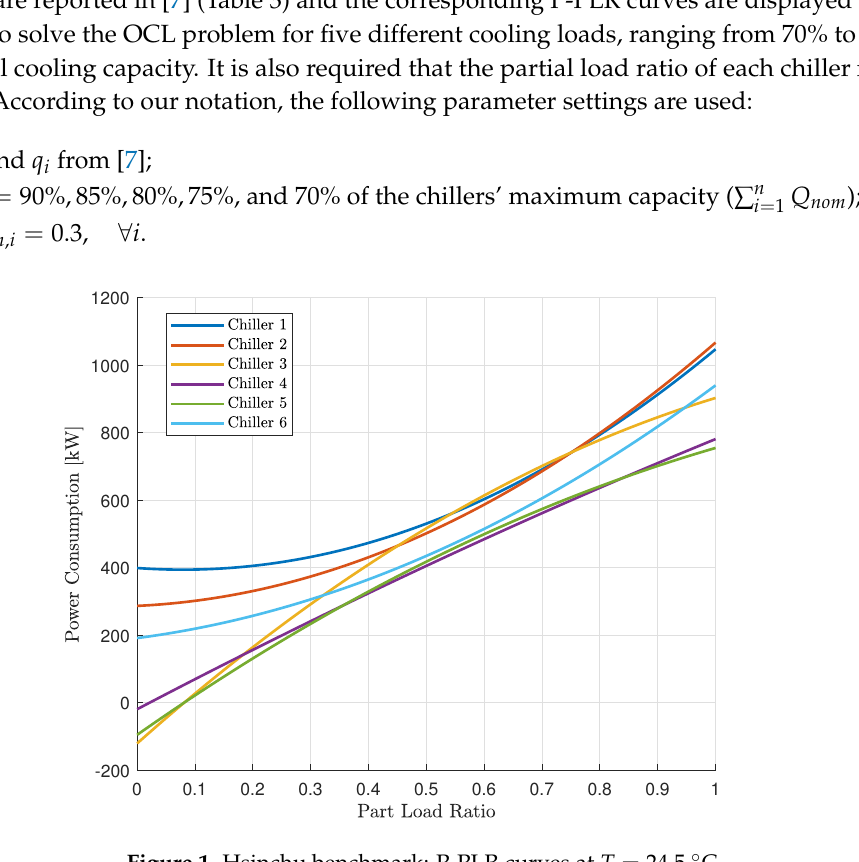
Figure 1. Hsinchu benchmark: P-PLR curves at T = 24.5 ◦